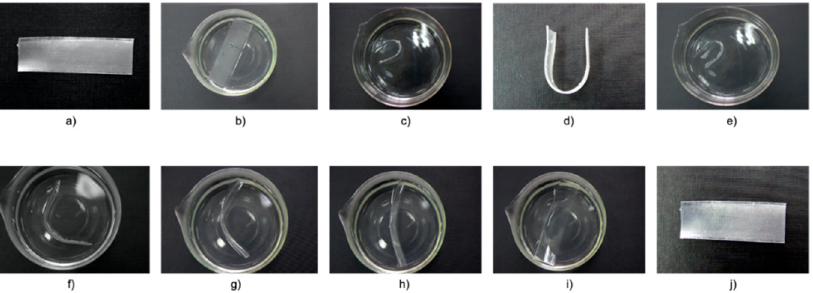
porary shape by the emergence in cold water; ( d ) fixed temporary shape; ( e ) immersing the tempo- rary sample in hot water to restore its initial shape; ( f – i ) recovering of the original sample shape at various stages; ( j ) sample after final recovery.